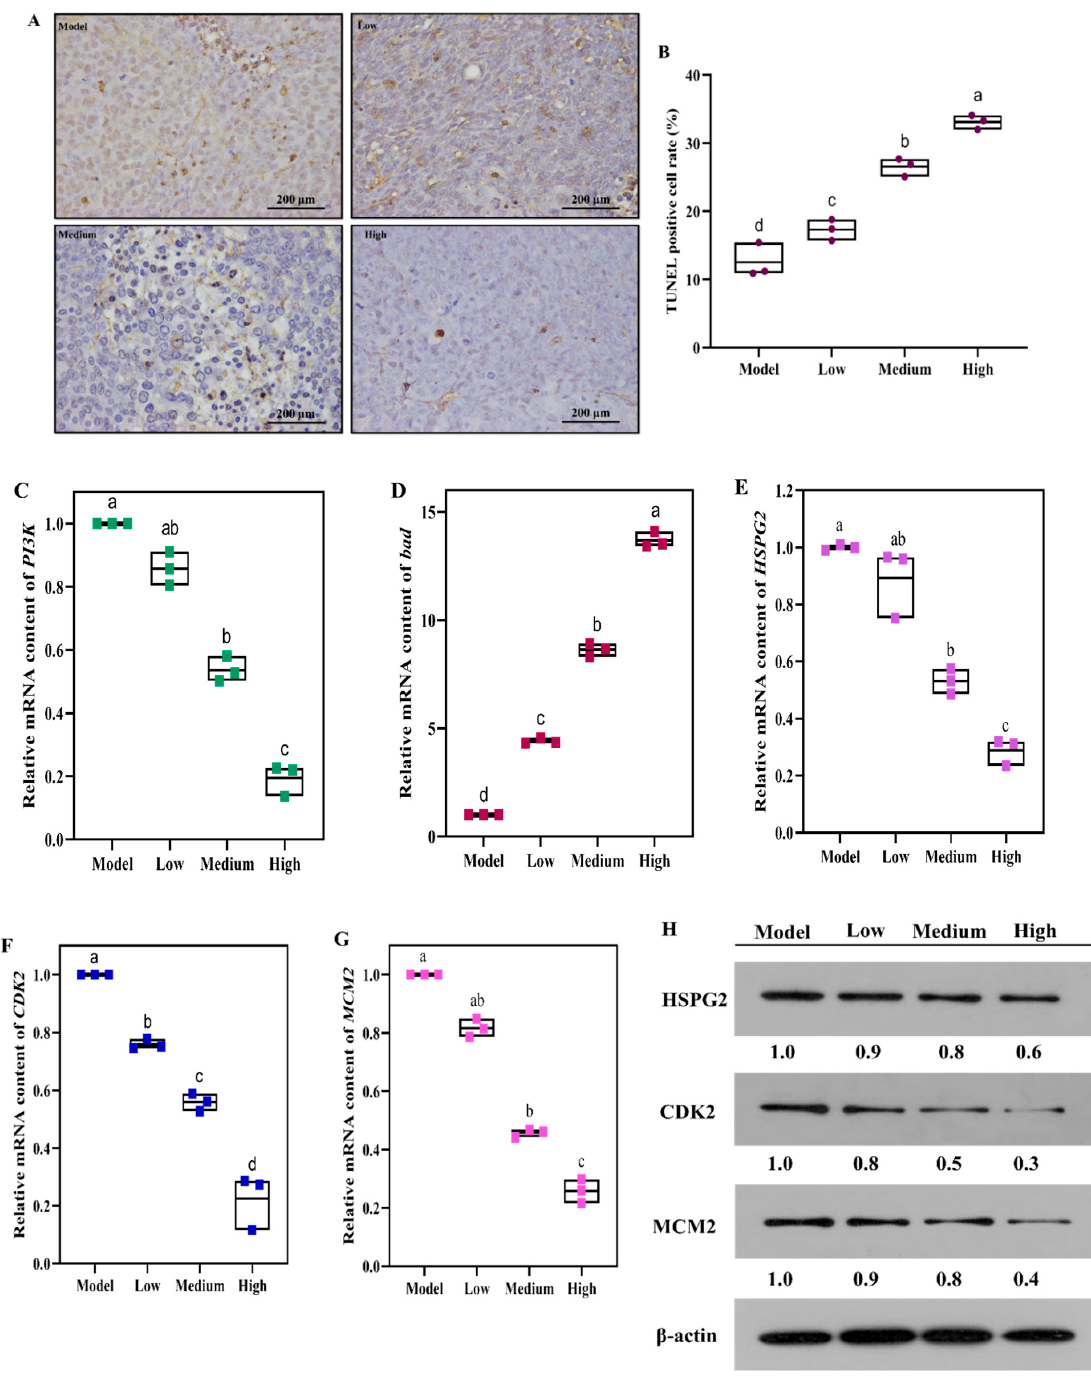
Figure 6. Effect of SCS on cell apoptosis in HT-29 xenograft tumor mice model. ( A ) Representation images of TUNEL staining. Xenograft tumor tissues were collected after sacrifice and sectioned for TdT-mediated dUTP nick-end labeling (TUNEL) staining; ( B ) Percentage of TUNEL-positive cells; ( C ) The relative mRNA content of PI3K ; ( D ) The relative mRNA content of bad ; ( E ) the relative mRNA content of HSPG2 ; ( F ) The relative mRNA content of CDK2 ; ( G ) The relative mRNA content of MCM2 ; ( H ) Western blot analyses of HSPG2, CDK2 and MCM2 proteins. Total RNA was extracted from xenograft tumor and the gene expression of cell proliferation markers was detected by RT-PCR, all results are expressed as mean ± SD ( n = 10). Different superscript letters for each column indicated significant differences ( p < 0.05) as compared to every other group. Western blot analysis using the indicated antibodies with β -actin as a loading control. The numeric ratios of relative expression were determined by densitometric analyses of the blots using the Image J software.